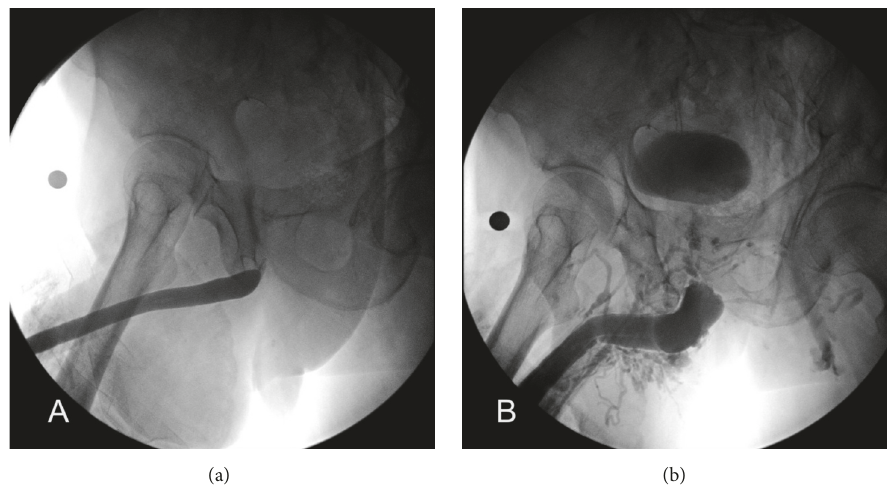
Figure 2: Retrograde urethrogram and voiding cystourethrogram. (a) Proximal bulbar urethral stricture. (b) Contrast extravasation to peribulbar